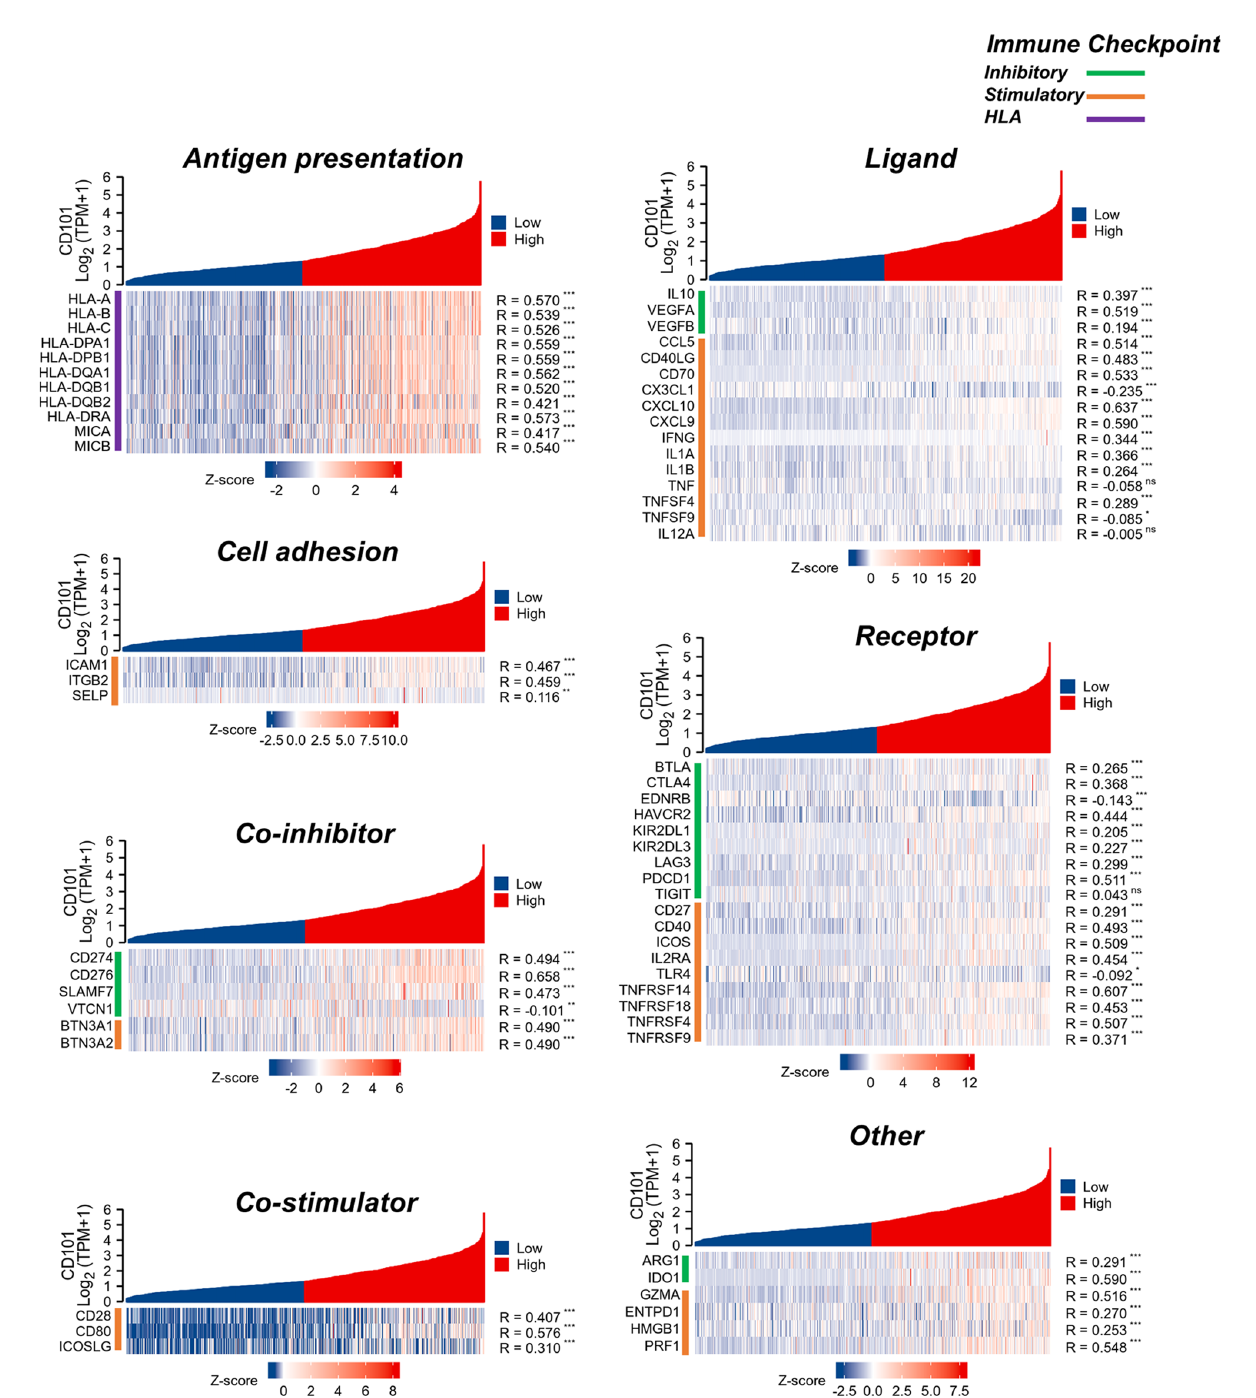
FIGURE 9 | Analysis of correlation between CD101 and immune-related gene in glioma based on the TCGA database. (ns, p ≥ 0.05, * p < 0.05, ** p < 0.01, *** p <